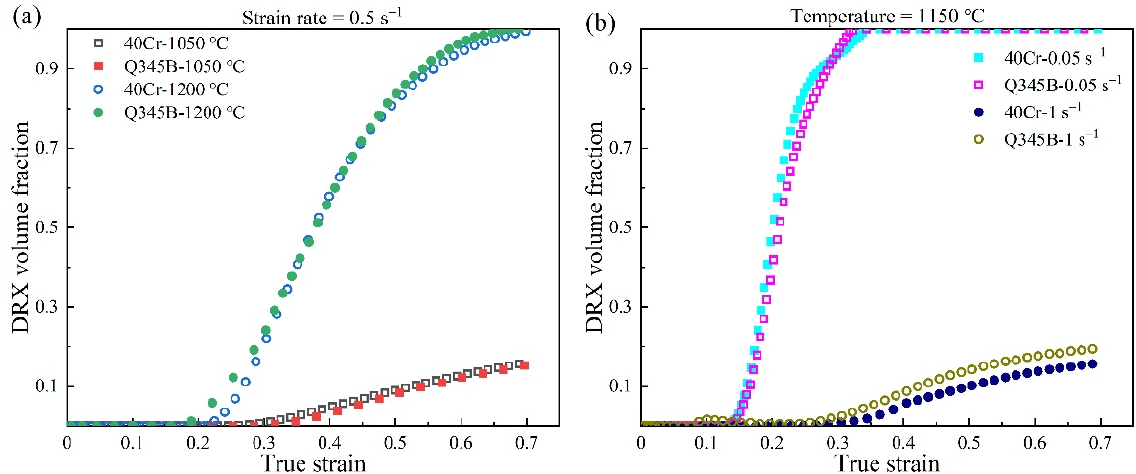
Figure 7. DRX volume fractions of 40Cr and Q345B at 0.5 s − 1 ( a ) and 1150 °C ( b ).